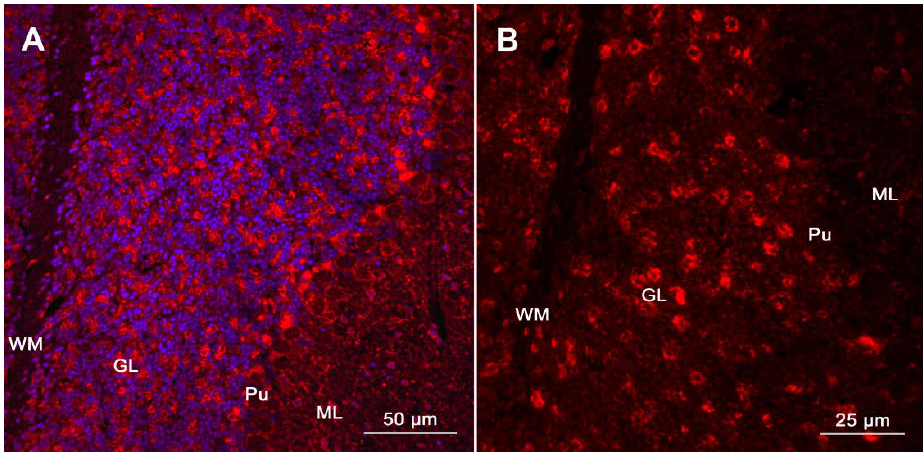
Figure 1. Detection of specific autoantibodies using tissue-based immunofluorescence. ( A ) . Immunoreactivity of a patient’s CSF with sagittal mouse brain sections is demonstrated via TIF (Cerebellum, magnification: 100 × , counterstaining of nuclei by Hoechst 33342 at 1:10,000). ( B ). Patient’s antibodies show a prominent immunolabeling of the neuropil of the granular layer (GL), whereas binding to the white matter (WM), Purkinje cell layer (Pu), and the molecular layer (ML) is less evident (magnification: 400 × ). This staining pattern is specific for neurexin-3alpha-antibodies and has been described in the first report of neurexin-3alpha-antibody associated autoimmune encephalitis [108]. Presence of antibodies targeting neurexin- 3alpha (a synaptic protein) in patient’s CSF was subsequently confirmed via CBA (Figure adapted from Loehrer et al. [109], reproduced with permission from John Wiley and